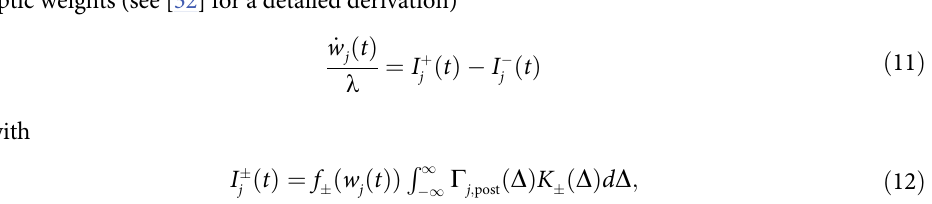
= 50ms, τ + = 22ms, μ = 0.01, α = −